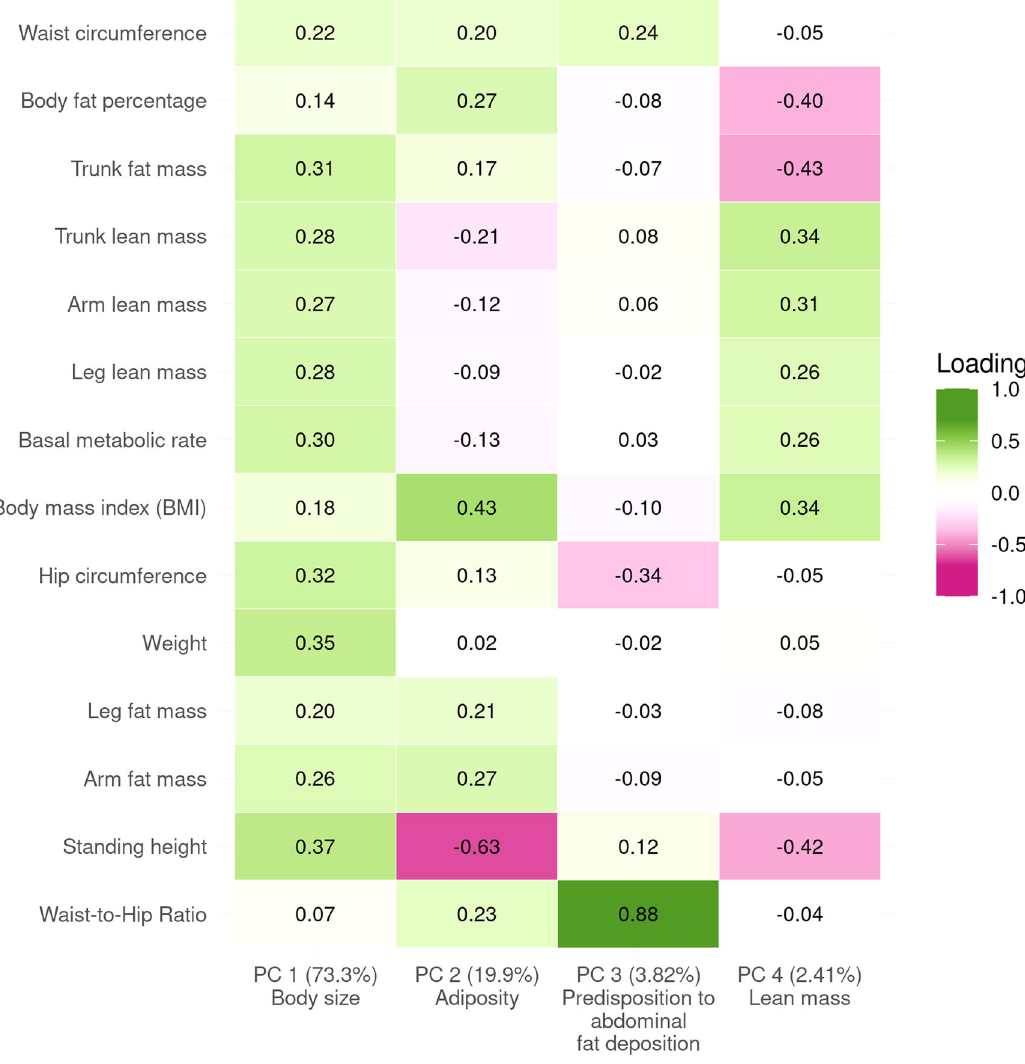
Fig. 2 The contributions of each trait to the fi rst four genetic principal components (PCs). The explained variance of each PC is included in parentheses along with the descriptive name used in the main text. The loadings presented here are those typically used in the principal component analysis (PCA), scaled such that the sum of the squared weights is equal to 1 (as opposed to the scaling used to obtain composite traits with a variance of 1). This provides a consistent scale and makes PCs more easily comparable with each